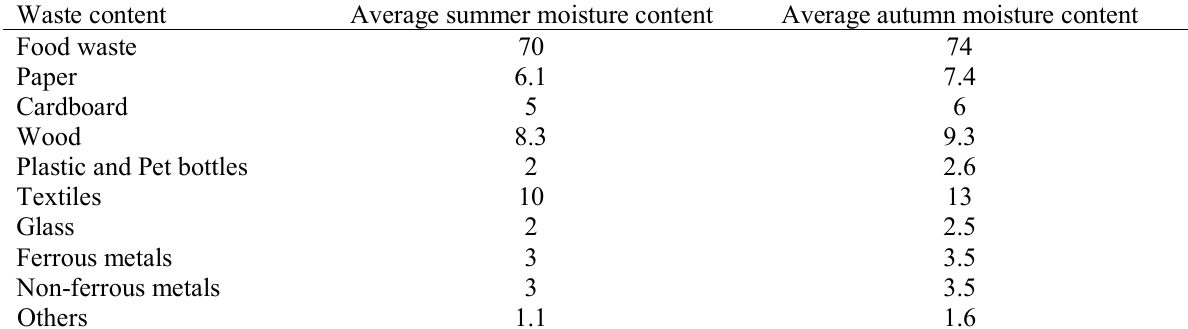
Table 1. The average moisture content of 6 days of sampling in the summer and autumn Waste